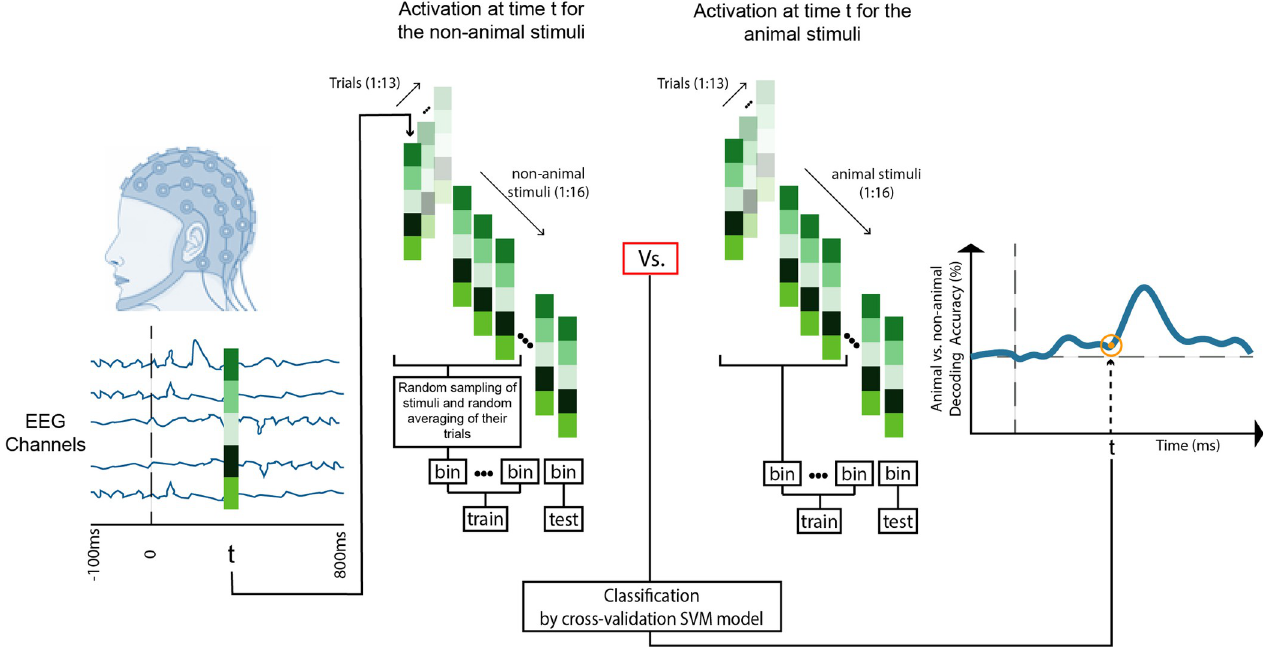
Fig 2. Animal vs. non-animal decoding. We extracted repetition trials of EEG responses to animal and non-animal stimuli at each time-point (for a given time-point t we had two matrices of 63 channels x16 stimuli x13 repetition trials of EEG responses to animal and non-animal stimuli). Before the classification, we randomly assigned each target stimulus with all its EEG trials to bins of size 2, 3 and 4 stimuli and randomly sub-averaged the trials within each bin. We trained a leave-one-bin-out cross-validation SVM model to discriminate animal from non-animal. At each time-point, the decoding accuracy is the average of 10,000 repetitions of the classification procedure described above. We repeated the entire process of each individual